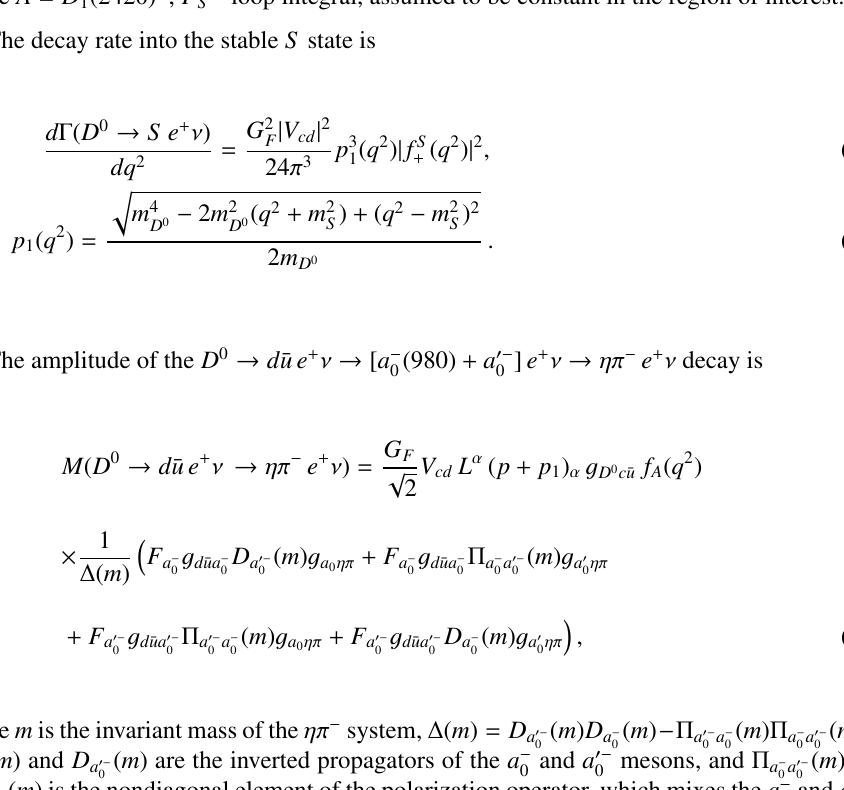
, a (cid:48) 0 ) e + ν 0 0